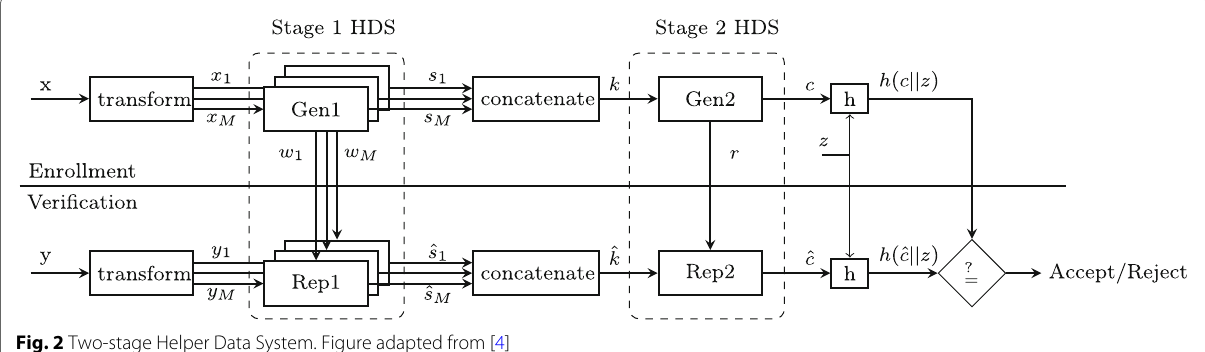
Fig. 2 Two-stage Helper Data System. Figure adapted from [4]